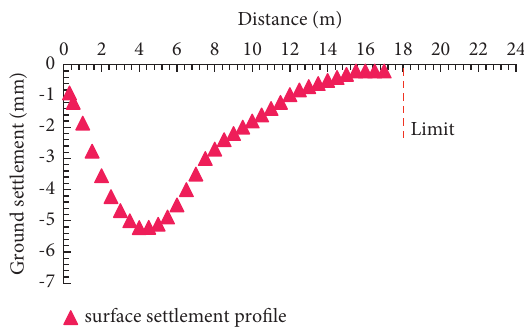
Figure 12: Influence of the application of steel bracing support with servo geotechnology axial loading capacity enhancement on ground surface influence zone settlement profile.